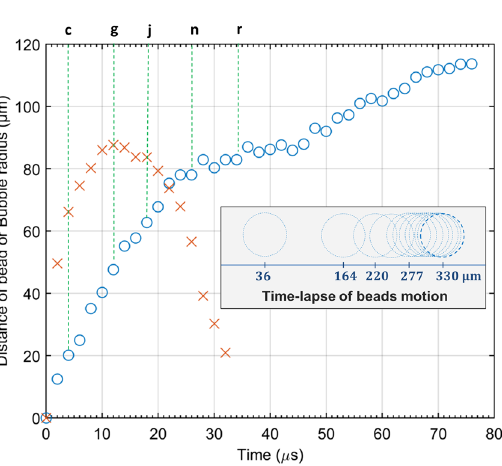
Figure 2. Evolution of the bubble at 2 μ s time steps. Image ( a ) shows a 42 μ m diameter sphere prior to the formation of the bubble. Image ( g ) shows the bubble at its maximal extent. Image (r) shows the shooting sphere after the bubble has dissolved.